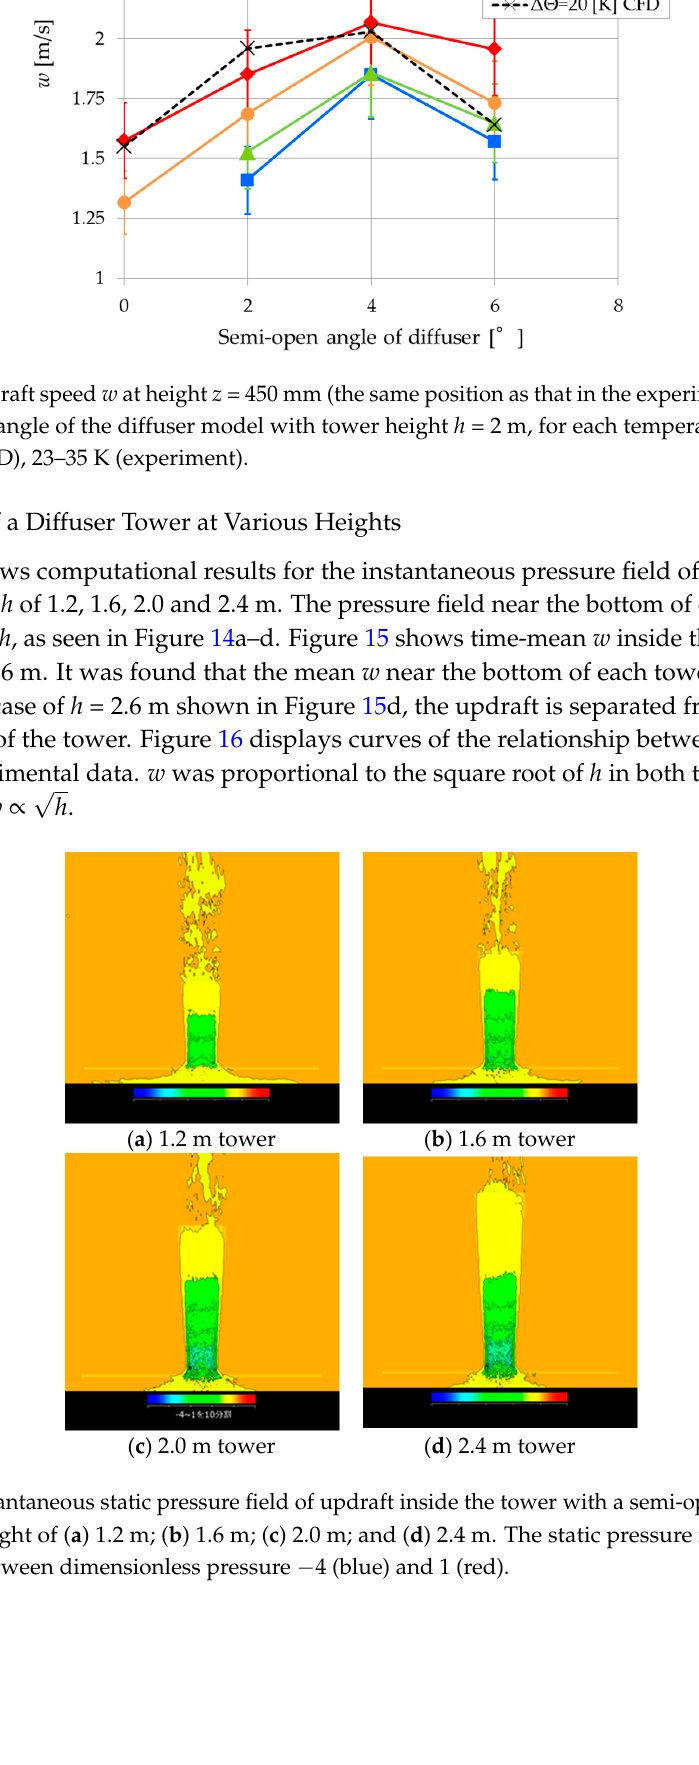
Figure 12. Instantaneous w ( left ); static pressure ( center ); and temperature ( right ) fields of updraft inside the tower with the height h = 2.0 m for each semi-open angle of ( a ) 0° (cylinder); ( b ) 2°; ( c ) 4° and ( d ) 6°. w , static pressure and temperature is expressed by 10 intervals between 0 and 5 m/s ( w